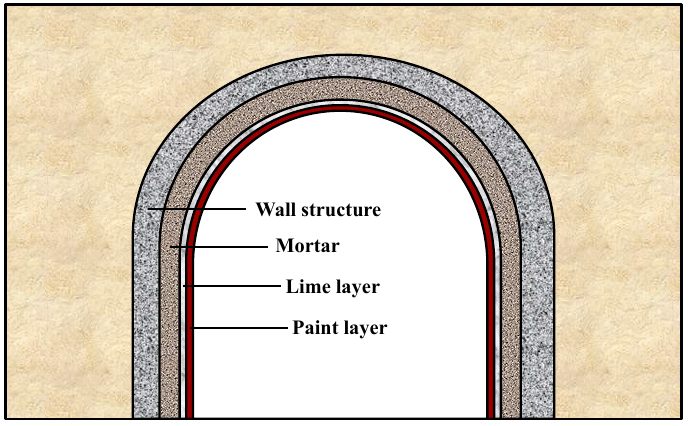
Figure 1. Structure diagram of tomb mural.